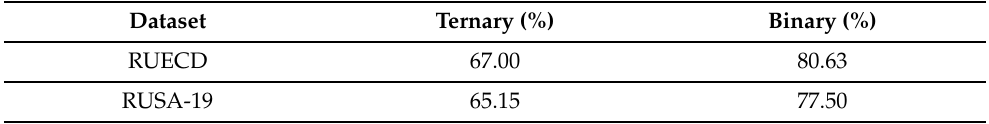
Table 4. Validation accuracy of our RU-BiLSTM